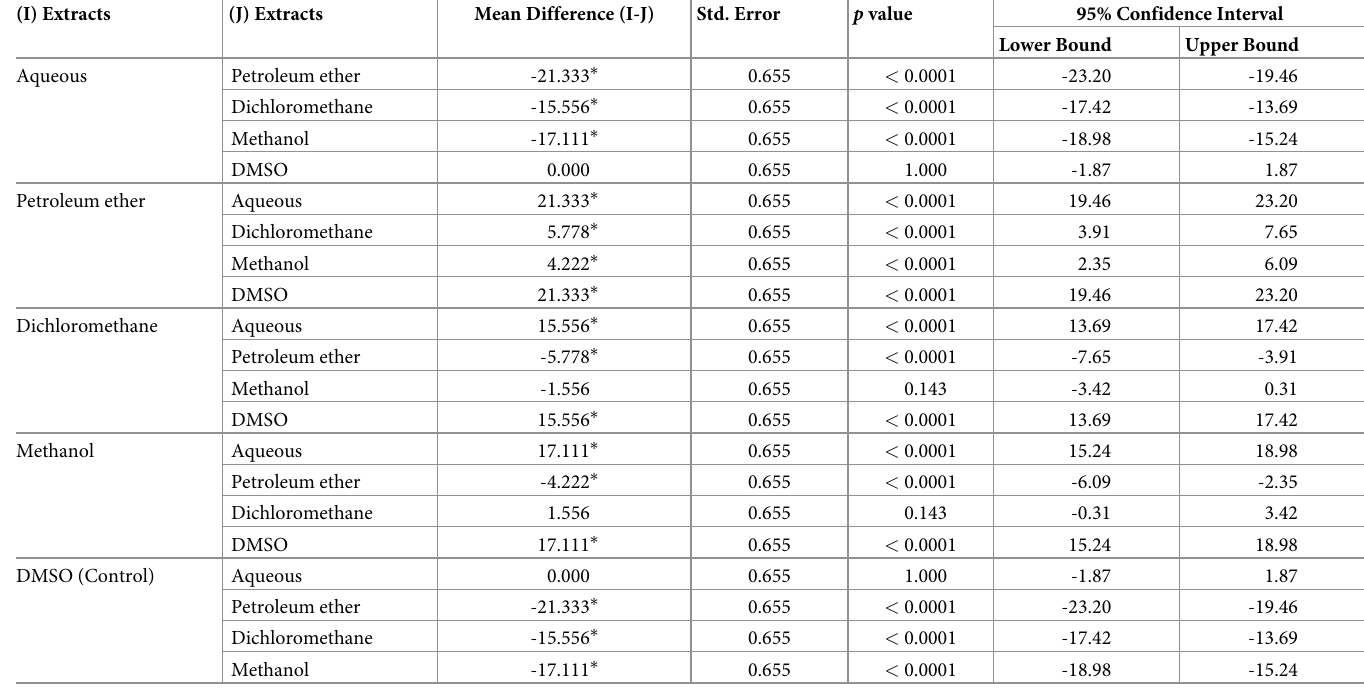
Table 3. Multiple comparisons of the zones of inhibition recorded for the various Eucalyptus grandis extracts and the